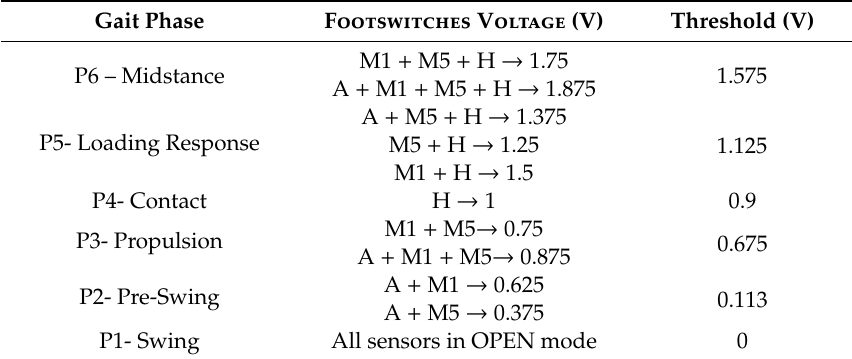
Table 2. Voltages provided by the FSR sensors in close